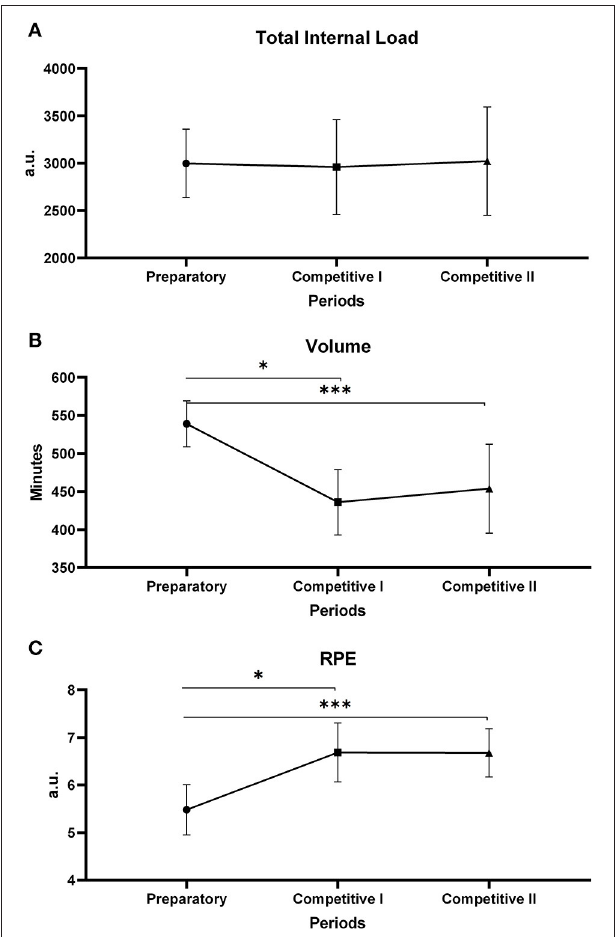
FIGURE 2 | (A) The total internal training load between periods. (B) Training volume between periods. (C) S-RPE between periods. *Difference between preparatory period and competitive period I, ***Difference between preparatory period and competitive period I.